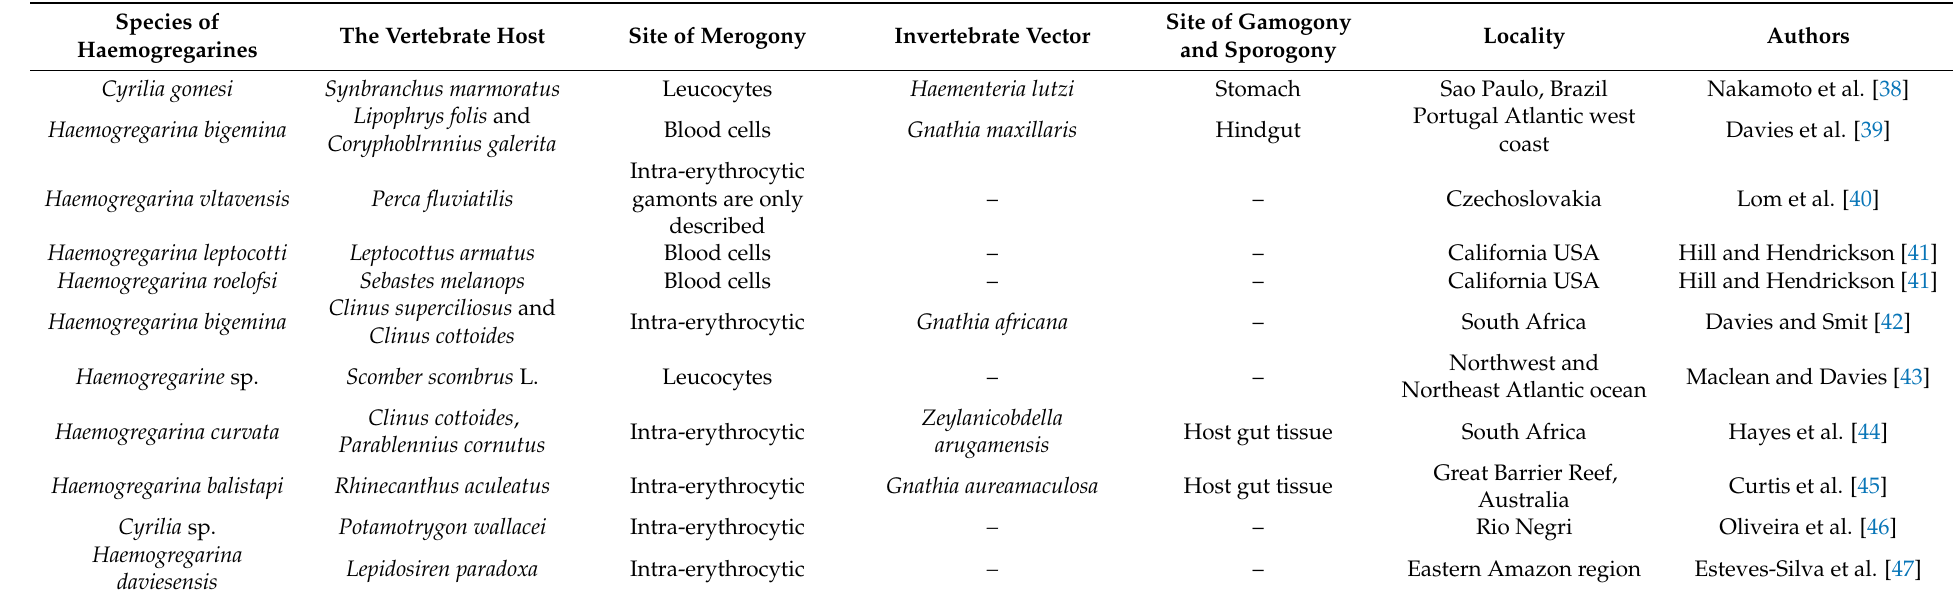
Table 2. Haemogregarines of